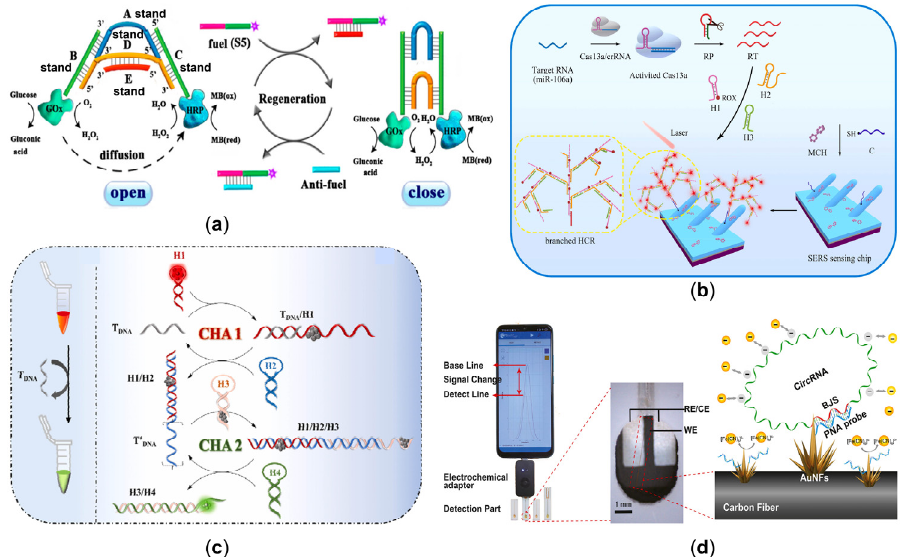
Figure 2. ( a ) Electrochemical DNA biosensor based on Mg 2+ -dependent DNAzyme cleavage recy- cling amplification and a regenerated DNA tweezer’s dynamical regulation of the enzyme cascade reaction [59]. (Reprinted from Analytical Chemistry , Kou, B.; Chai, Y.; Yuan, Y.; Yuan, R. Dynamical